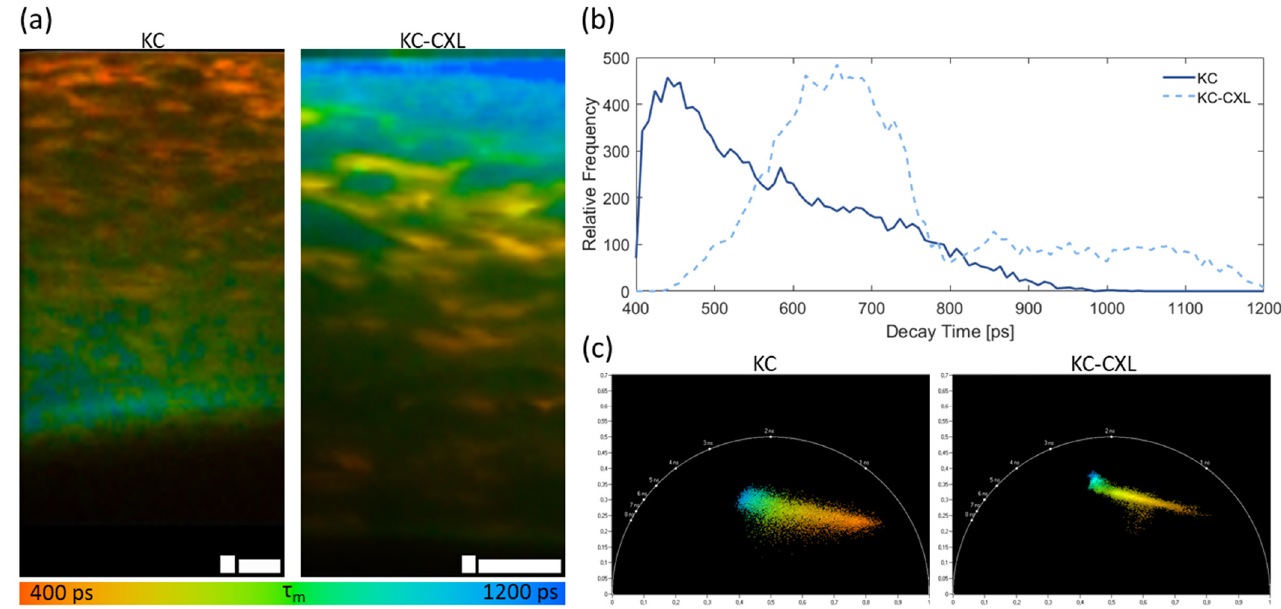
Figure 7. Cross-sectional autofluorescence (AF) lifetime images color-coded for mean AF lifetime (as indicated in the color bar) of the keratoconus (KC) and keratoconus crosslinked (KC-CXL) corneas 24 h after treatment ( a ), corresponding mean AF lifetime decay distributions ( b ) and phasor plots ( c ). Images were acquired with the multiphoton tomograph MPTflex (JenLab, GmbH) using an excitation wavelength of 760 nm . Fluorescence lifetime data analysis was performed using SPCImage vs 6.2 (Becker & Hickl GmbH, Berlin, Germany). Scale bars = 20 μm .